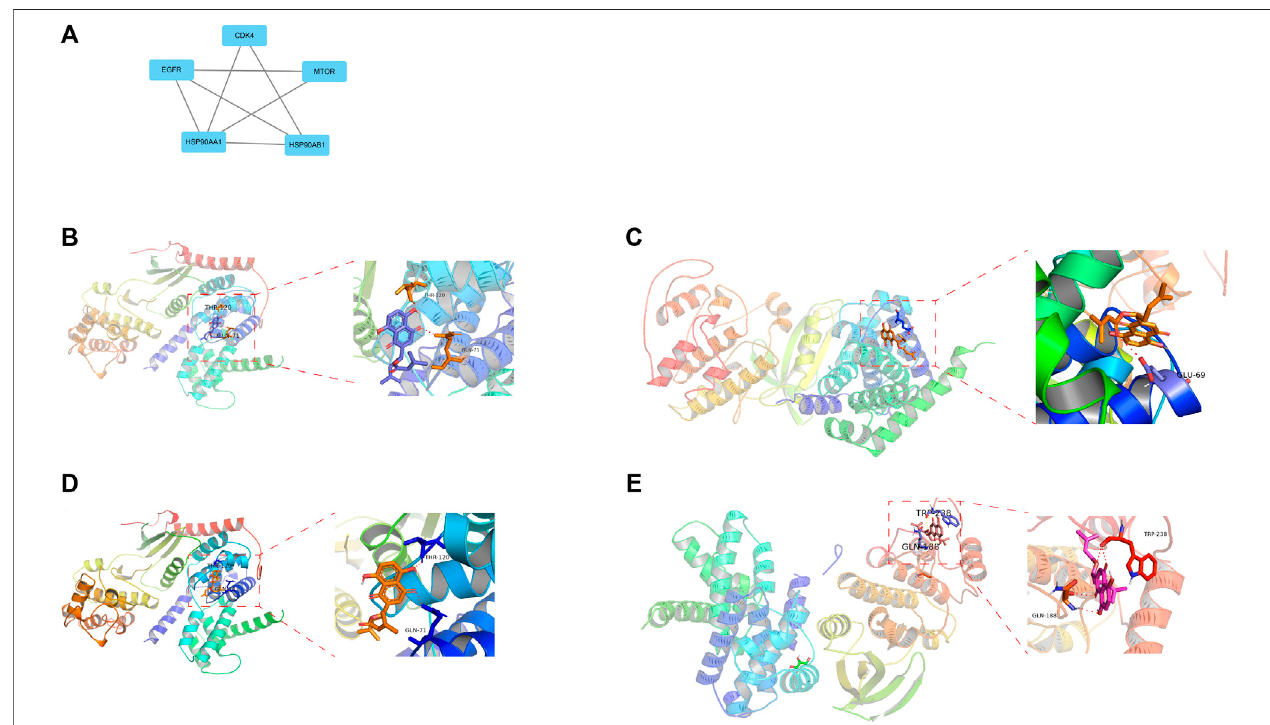
FIGURE 9 | Five core drug targets (A) , DMSA docked with the 6p8g (B) , 2w9z (C) , 6p8e (D) , and 2w96 (E) conformations of